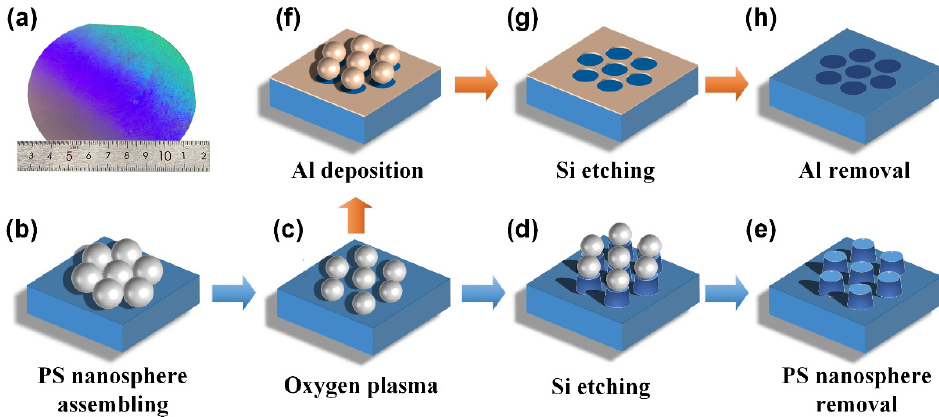
Figure 1. The schematic diagram of nanopillars and nanoholes experimental flow based on the air–liquid interface self-assembly method: ( a ) The sample of PS nanospheres template mask on Si substrate, ( b ) PS nanospheres assembling, ( c ) oxygen plasma, ( d ) Si etching, ( e ) PS nanospheres removal, ( f ) Al deposition, ( g ) Si etching, ( h ) Al removal.